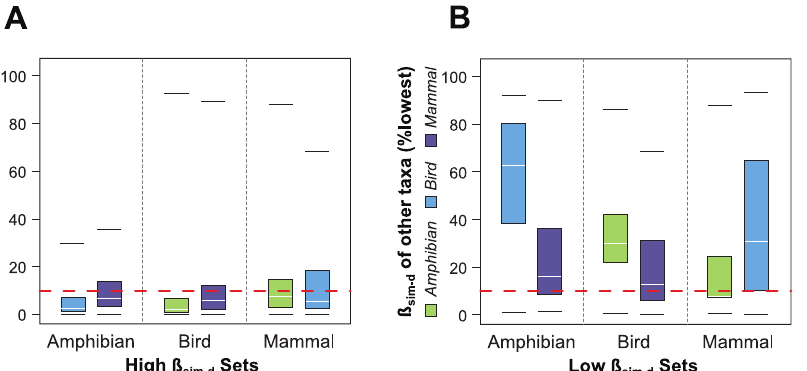
Figure 5. Levels of Beta-Diversity for Vertebrate Taxa within Areas of High and Low Beta-Diversity of Amphibians, Birds, and Mammals Percentage sets of the highest (A) and lowest (B) 2.5% of beta-diversity ( b sim-d ) grid cells for one taxon ( x -axis) contain a range of b sim-d levels for the other taxa ( y -axis), as shown by the box plots (white lines within boxes indicate the median; top and bottom box edges indicate first and third quartiles; black lines indicate minimum and maximum percentage rank of b sim-d ). The red dashed line indicates the highest or lowest 10% of b sim-d .